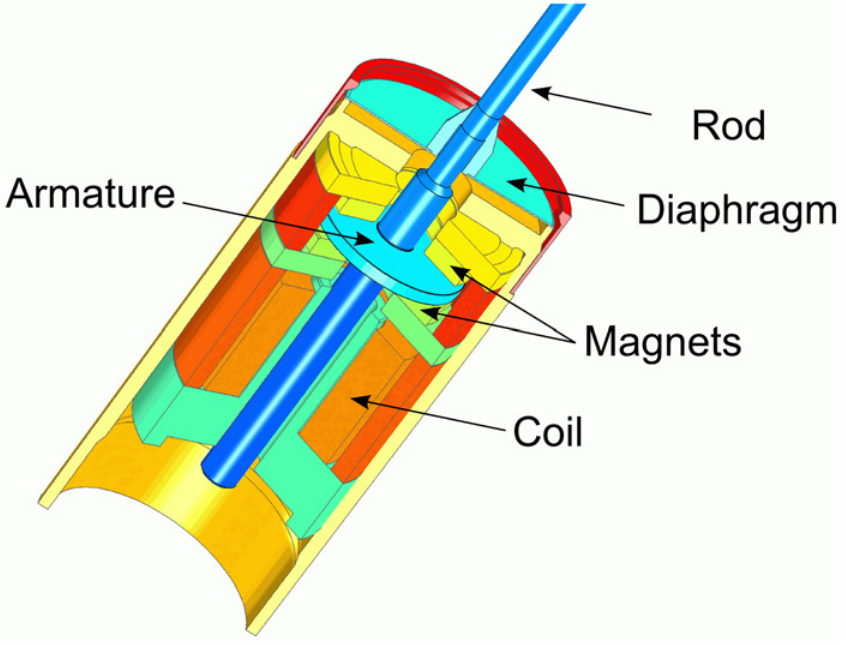
Fig 2. Section view of the Codacs actuator. (CC-BY by courtesy Cochlear Ltd.).